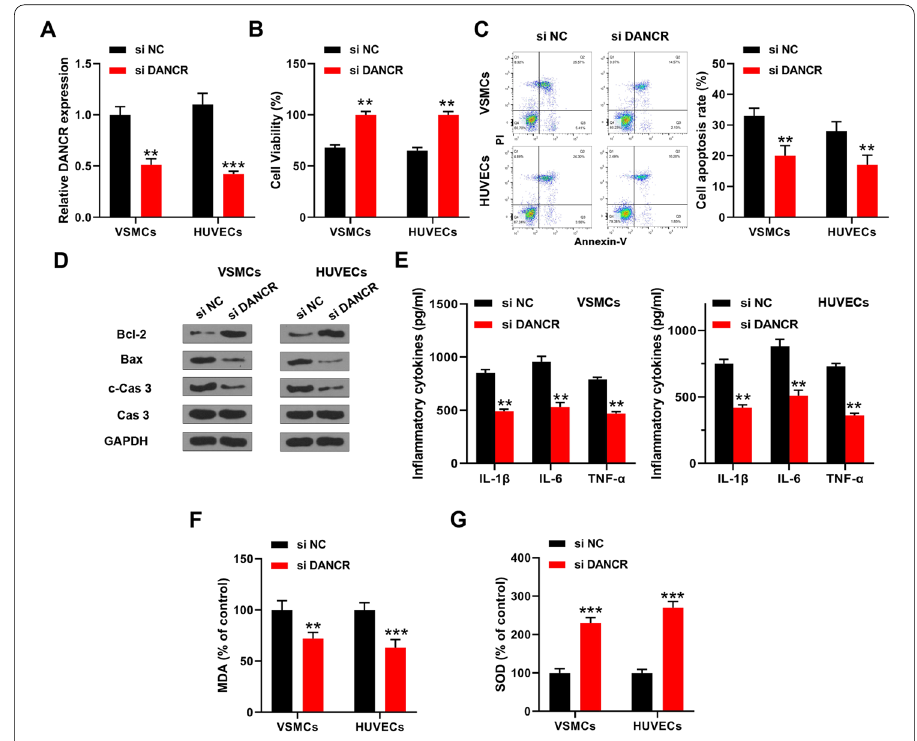
Fig. 2 DANCR downregulation ameliorated ox-LDL-induced endothelial injury in vitro. VSMCs and HUVECs were transfected with si-DANCR or si-NC and then treated with 50 μg/ml ox-LDL for 48 h. A DANCR expression was detected by qRT-PCR. B CCK-8 assay. C Flow cytometry assay. D Expression of apoptosis-related proteins was detected by Western blot. The original images are shown in Additional file 1. E Expression of inflammatory cytokines was detected by ELISA assay. F , G Levels of MDA ( F ) and SOD ( G ) were evaluated by specific detection kits. Each experiment was repeated three independent times. **p < 0.01 and ***p <